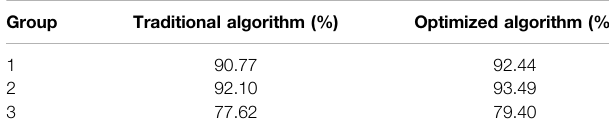
TABLE2| Globalavailabilitycomparisonbetweenthetraditionalalgorithmandthe optimized